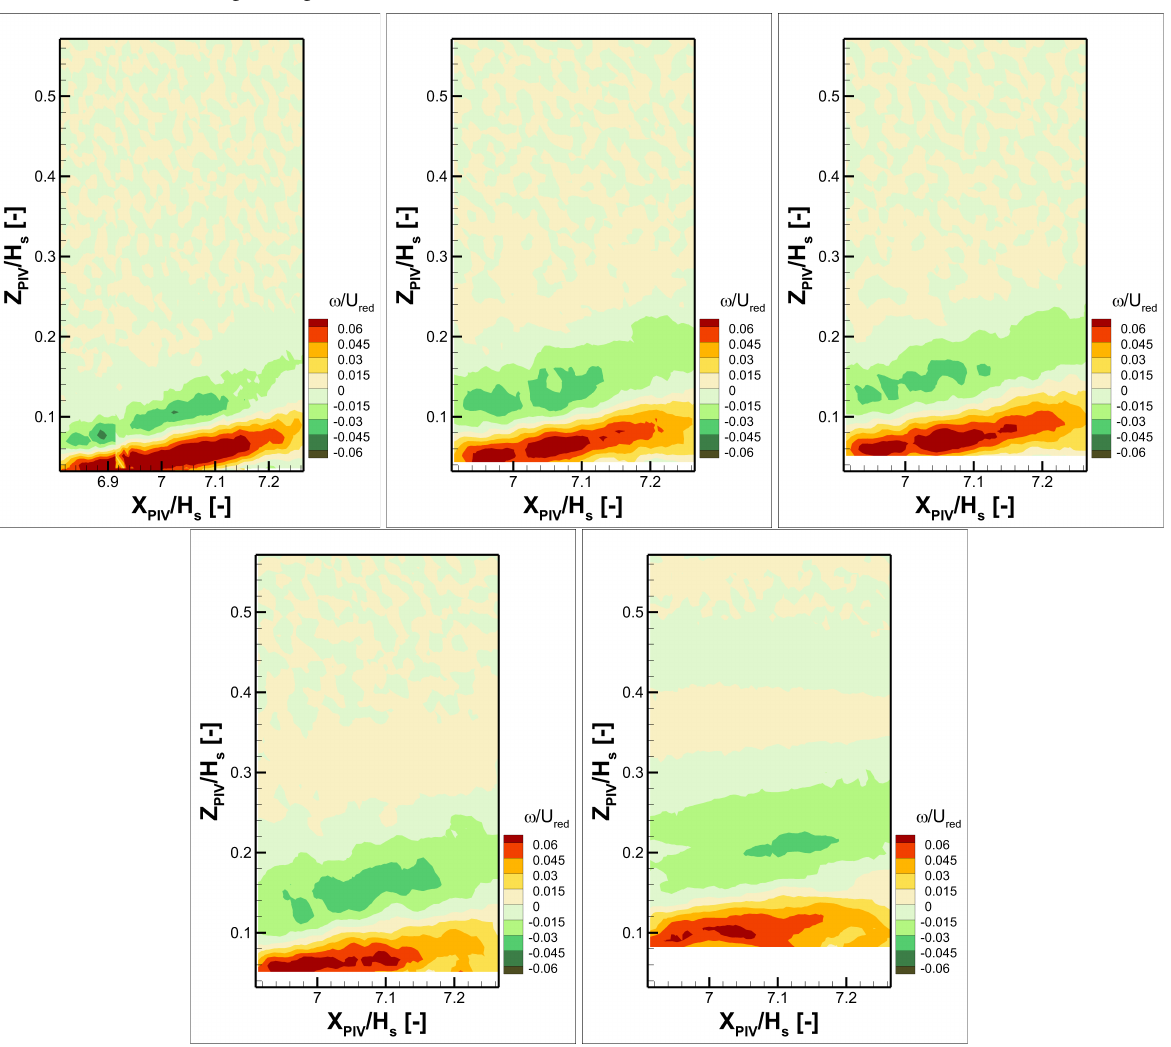
Fig. 3. The first POD modes of vorticity for the surface boundary layer SBLM1-SBLM5 with a reference spire distance D4, from left upper corner to right bottom corner. H S is the inner height of the test section. Flow comes from left to right.